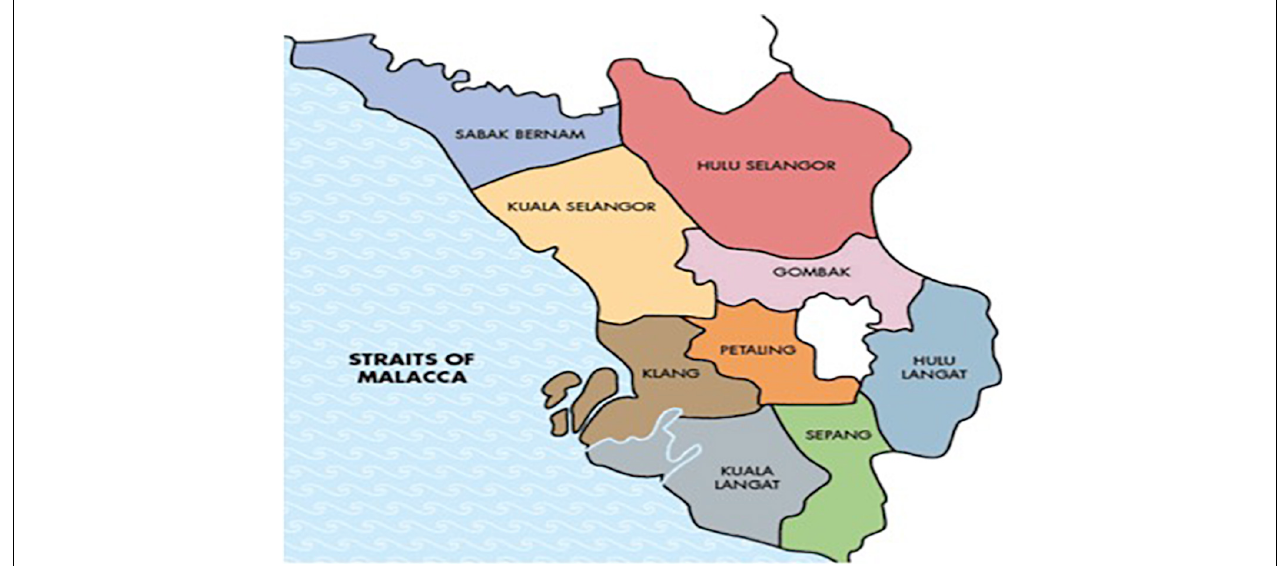
FIGURE 1 | Map of Selangor and its districts (“Selangor state,”